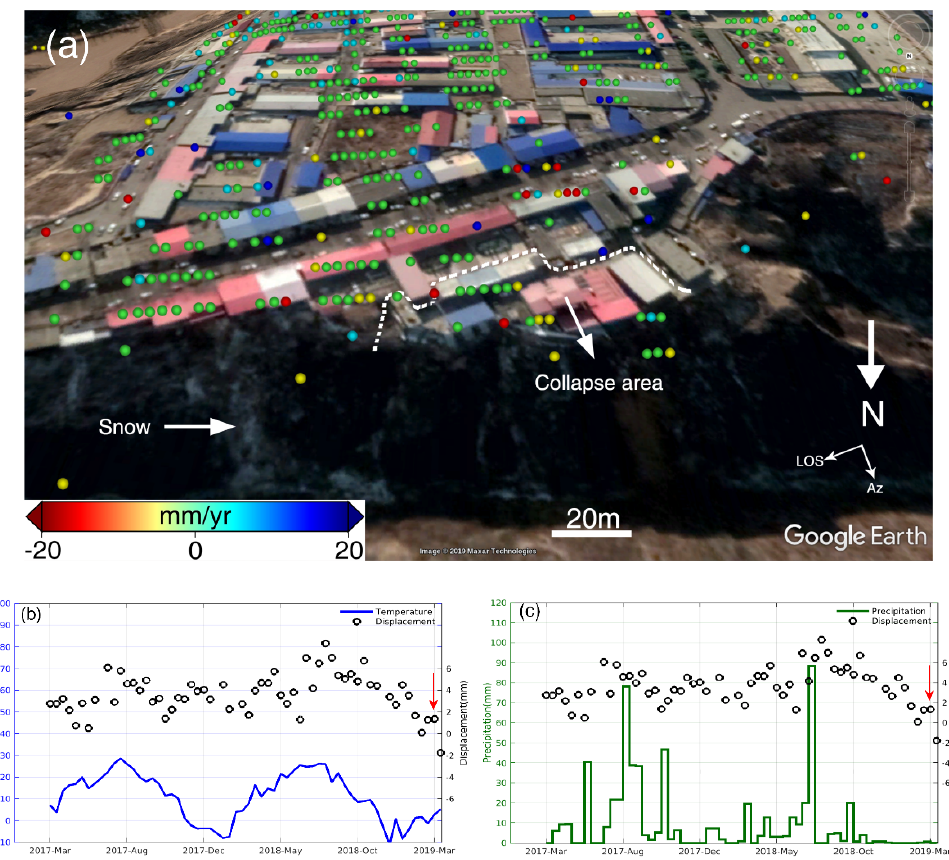
Figure 8. ( a ) Mean LOS displacement rates of the Xiangning landslide measured from Sentinel-1 datasets overlaid on Google Earth image obtained at 20 February 2019, the white dashed line represents the boundary between the collapsed area and stable area. ( b ) and ( c ) are the averaged time series displacement of the Xiangning landslide versus temperature and precipitation, respectively.